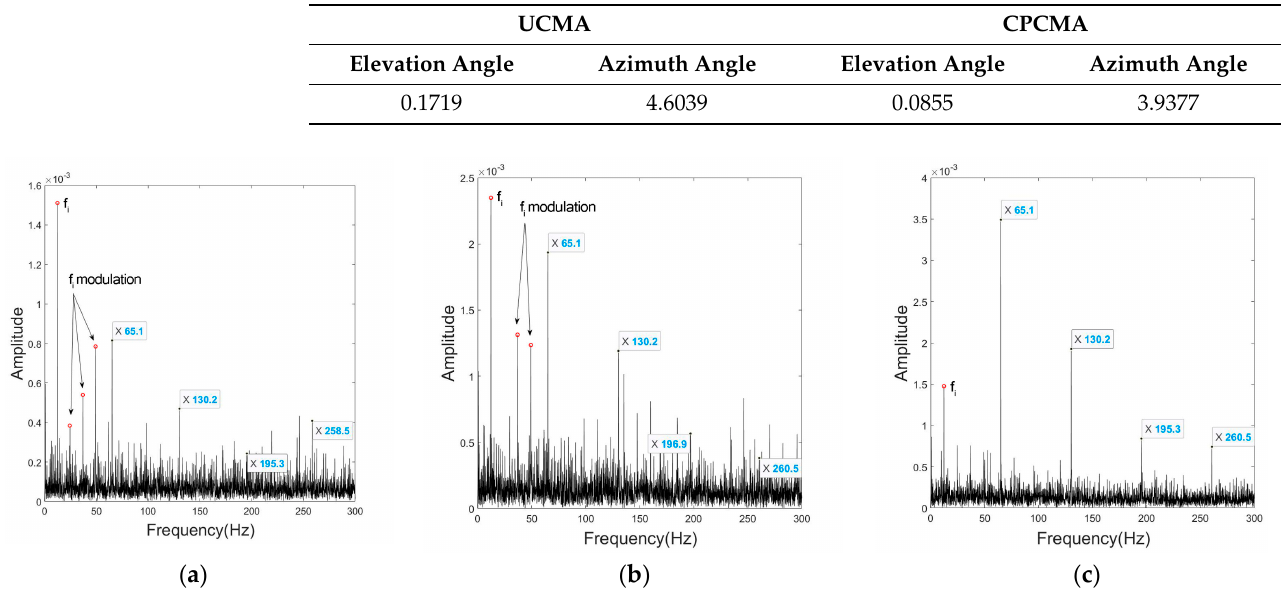
Figure 11. Envelopes under outer race fault condition at 725 rpm of: ( a ) non − processed mono signal; Table 18. DOA estimation by UCMA-ESPRIT for inner race fault signal at 725 rpm.